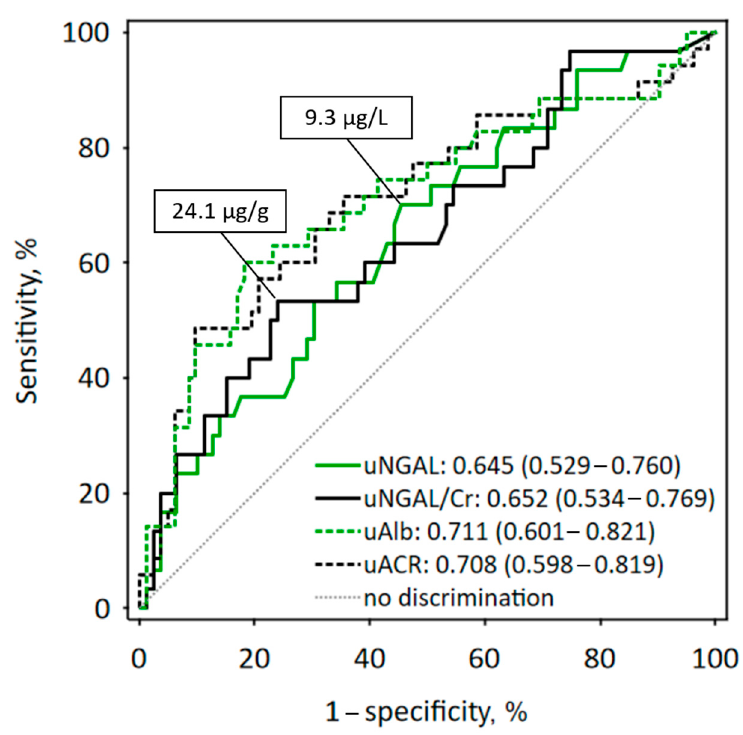
Figure 2. Receiver operating characteristic (ROC) curves for baseline urine NGAL concentration (uNGAL; solid green line) and urine NGAL/creatinine ratio (uNGAL/Cr; solid black line) in the prediction of ≥ 10% decrease of eGFR during the one-year follow-up. The cut-off values are reported on the graph. For comparison, ROC curves for urine albumin concentration (uAlb) and urine albumin/creatinine ratio are presented using dashed lines. The values of area under the ROC curves (AUC) are shown with 95% confidence intervals in brackets. Table 4. Correlations between the baseline urine NGAL concentrations (uNGAL) and NGAL to creatinine ratios (uN- GAL/Cr) and the changes in eGFR observed during the study as well as the eGFR based on mean serum creatinine during the